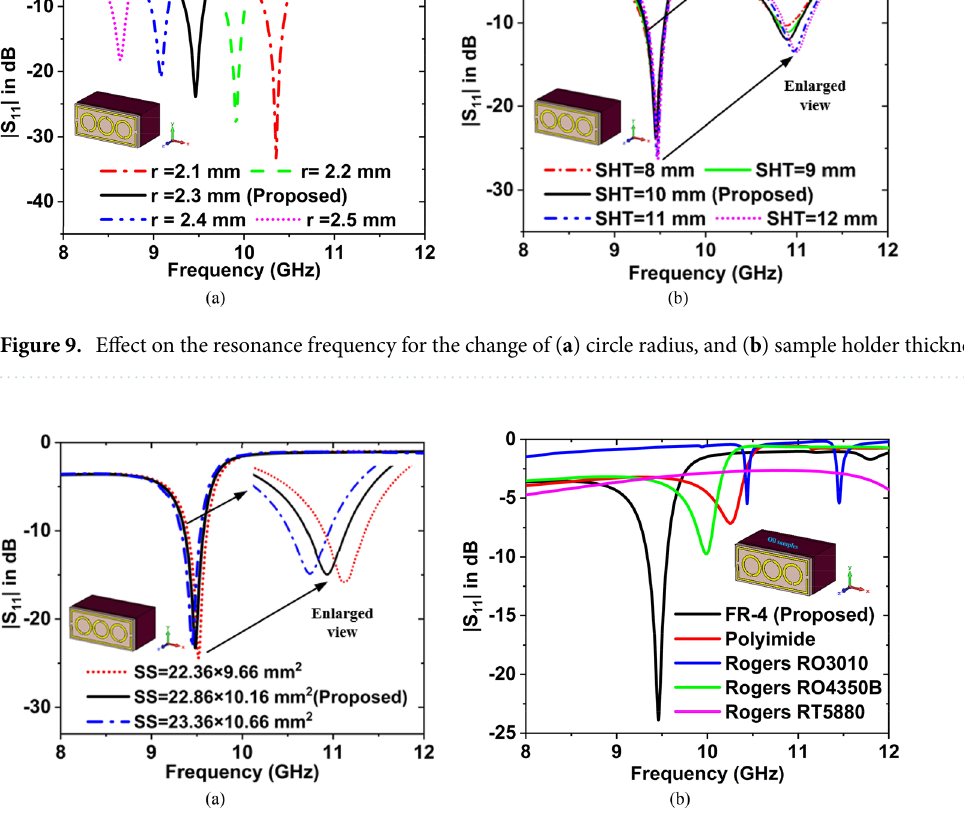
Figure 10. Effect on the resonance frequency for the change of ( a ) substrate size, and ( b ) substrate